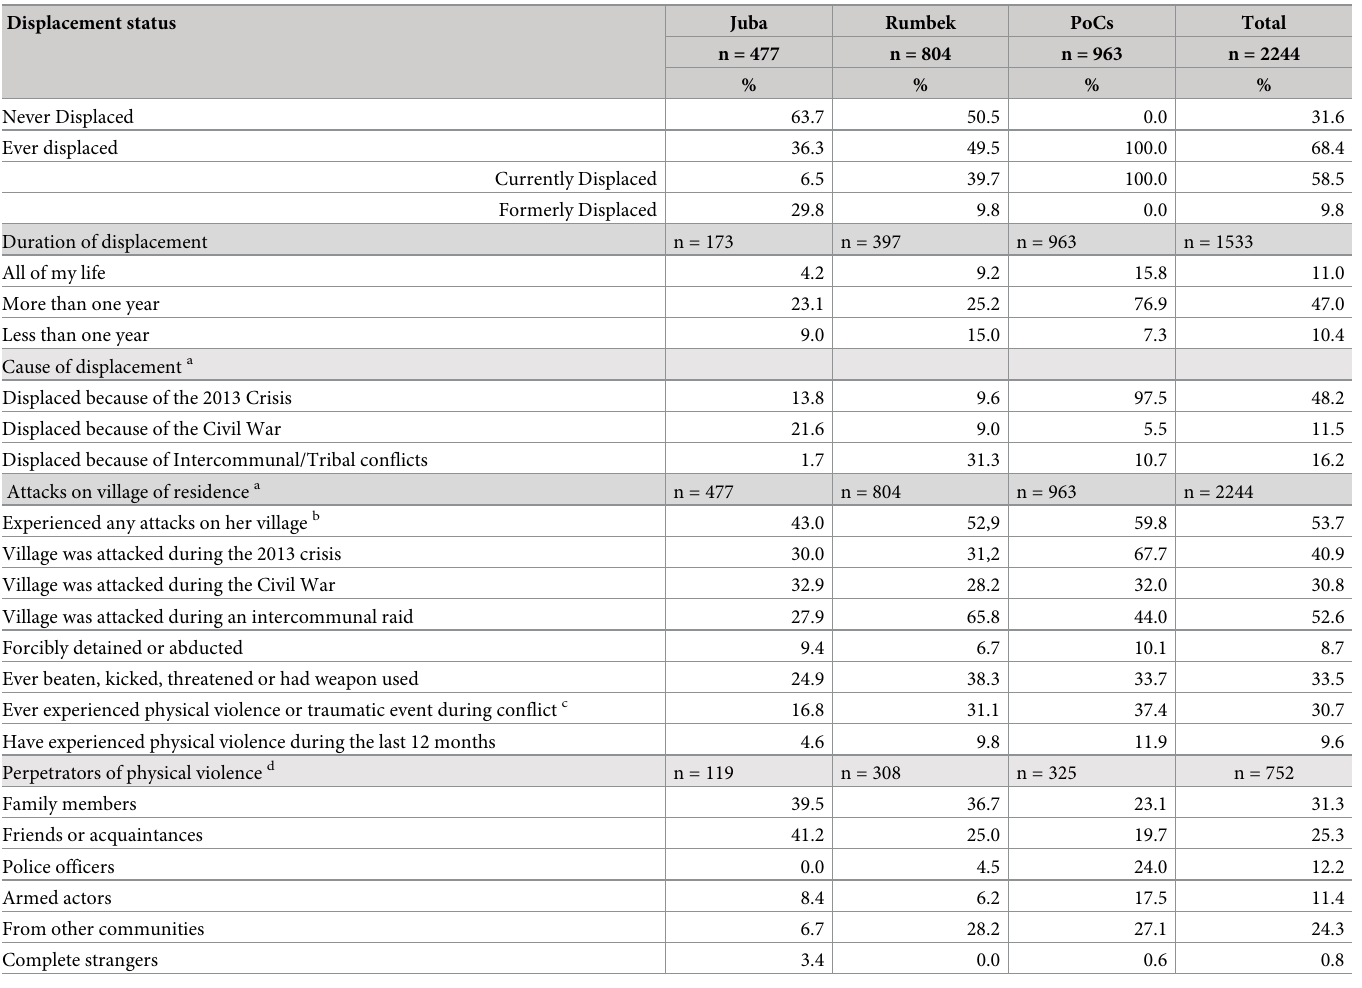
Table 3. Experiences of